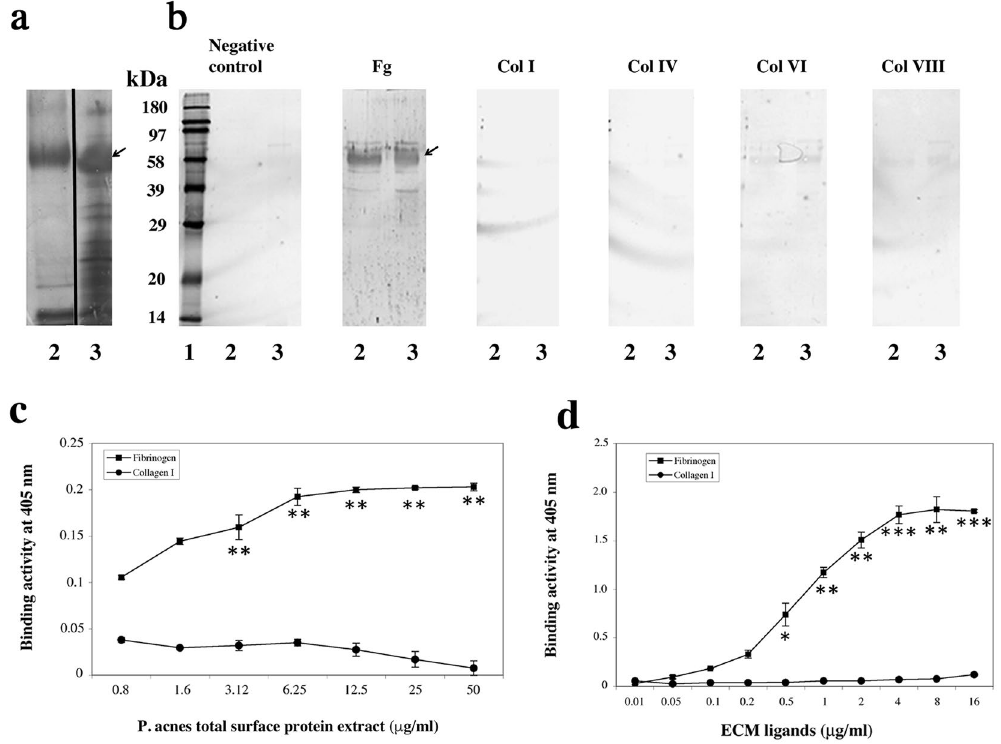
Figure 1. Identification of a 58 kDa P. acnes surface protein recognized by human fibrinogen. ( a ) Proteins were separated by 12.5% SDS-PAGE (10 μ g per lane) and detected by silver staining. ( b ) Proteins (50 μ g per lane) were incubated with biotinylated human fibrinogen, collagens I, IV, VI and VIII (Fg, ColI, ColIV, Col VI, Col VIII; 0.1 μ g/ml) and detected with HRP-streptavidin. Control experiments were performed with HRP-streptavidin alone. Lane 1: molecular weight standards. Lanes 2 and 3: surface proteins extracted at 60 °C in PBS and at 45 °C in 1 M LiCl, respectively. The arrow indicates the position of the 58 kDa protein. ( c ) Immobilized proteins (0.8 to 50 μ g/ml) were probed with biotinylated fibrinogen (0.5 μ g/ml). ( d ) Immobilized proteins (25 μ g/ml) were probed with biotinylated fibrinogen (0.1 to 16 μ g/ml). Data are presented as the mean ± standard deviation of three independent experiments. Statistical significance is indicated by * P ≤ 0.05, ** P ≤ 0.01, *** P ≤